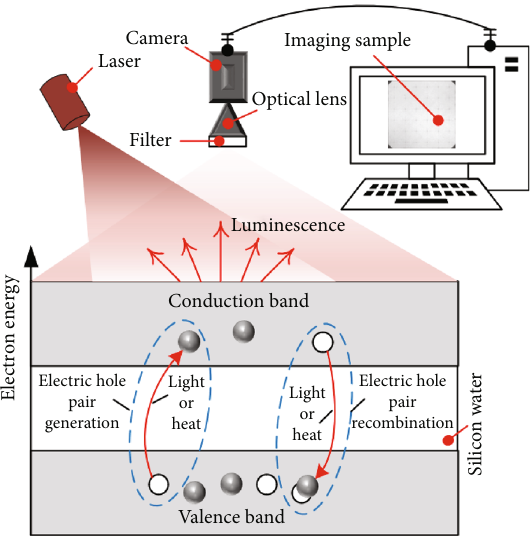
Figure 1: The imaging principle of PL